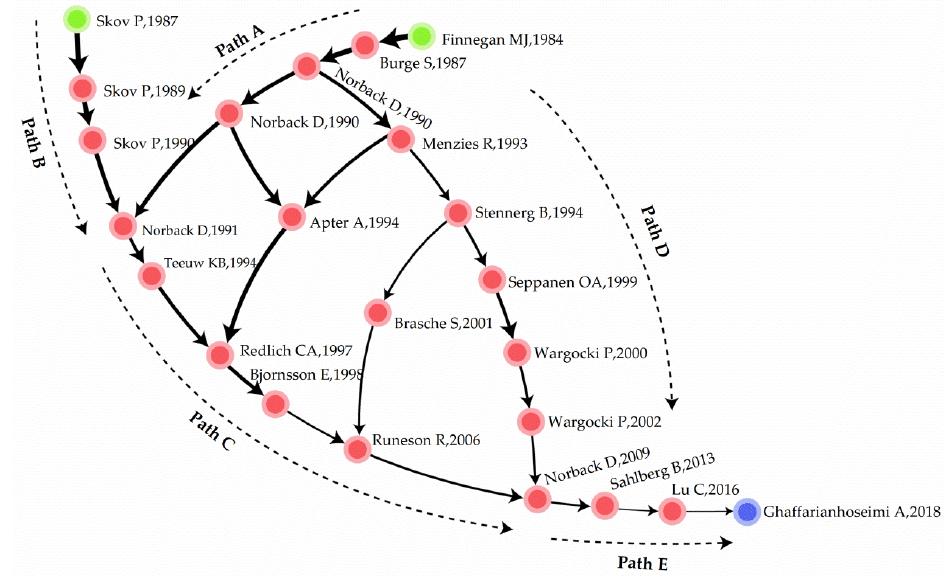
Figure 7. Main path analysis of the SBS [21 –